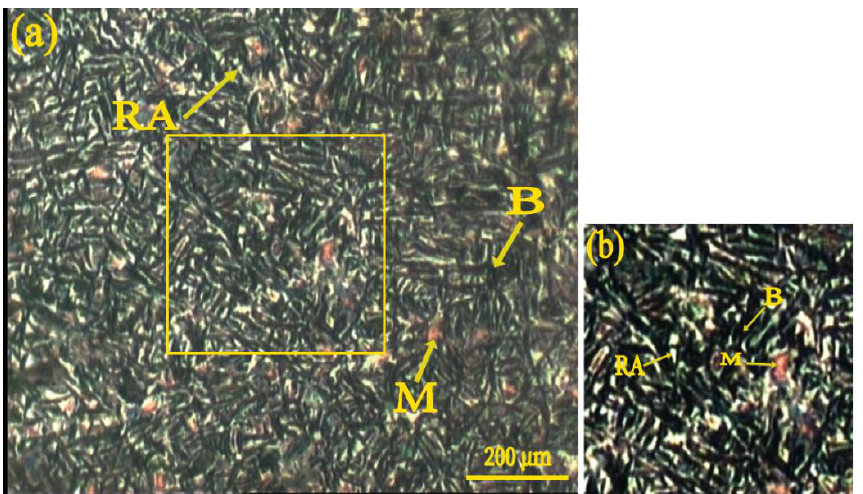
Figure 5. ( a ) Triple-step etching method (2% nital + 10% ammonium persulfate solution + warm Marble’s reagent at 30 °C). ( b ) Enlarged image view of the square shown in ( a ). The abbreviations B, M and RA represent bainite, martensite and retained austenite phase constituents,